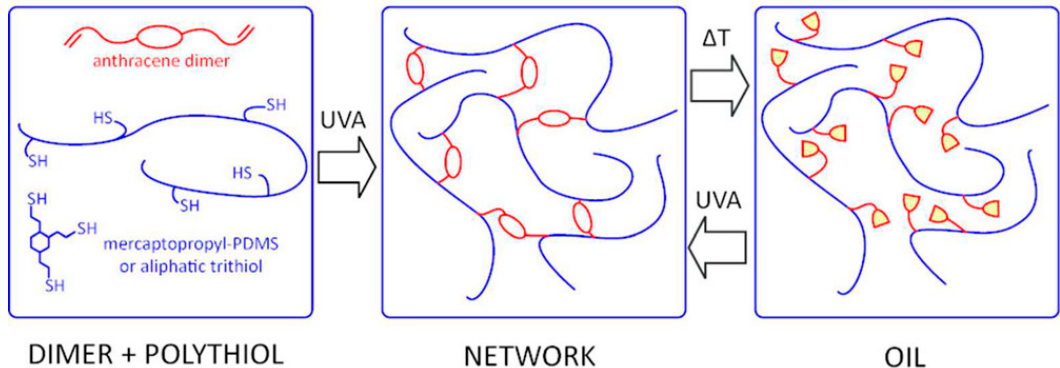
Figure 35. The cross-linked recyclable polymers. Reprinted/adapted with permission from Ref. [136]. Copyright 2017 American Chemical